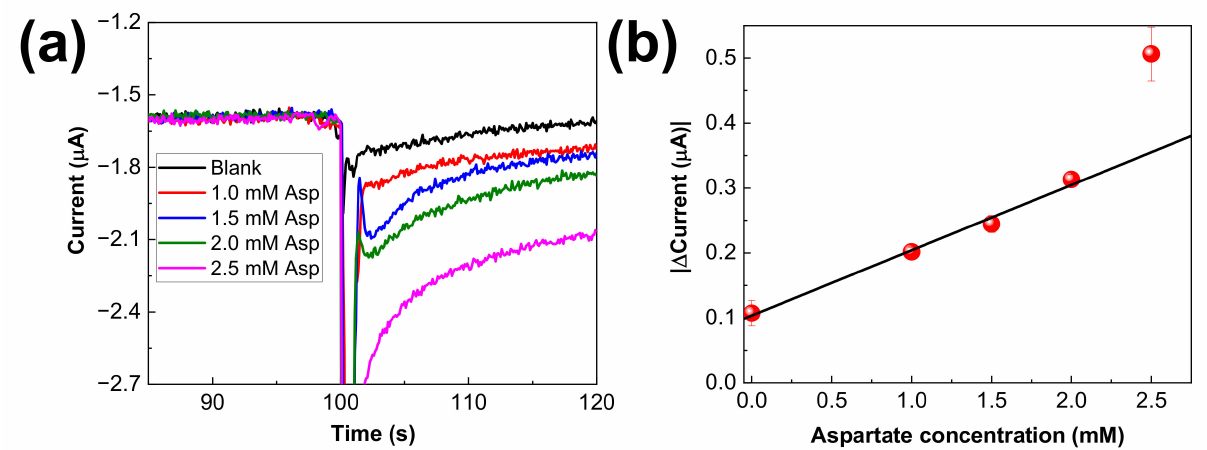
Figure 5. ( a ) Amperometric responses of GluOx–ASTENs/PB/SPCEs in 50 mM buffer (pH 6.0) with successive additions of different concentrations of aspartate at − 0.1 V in the presence of 150 µ M α -ketoglutarate. ( b ) Corresponding linear calibration